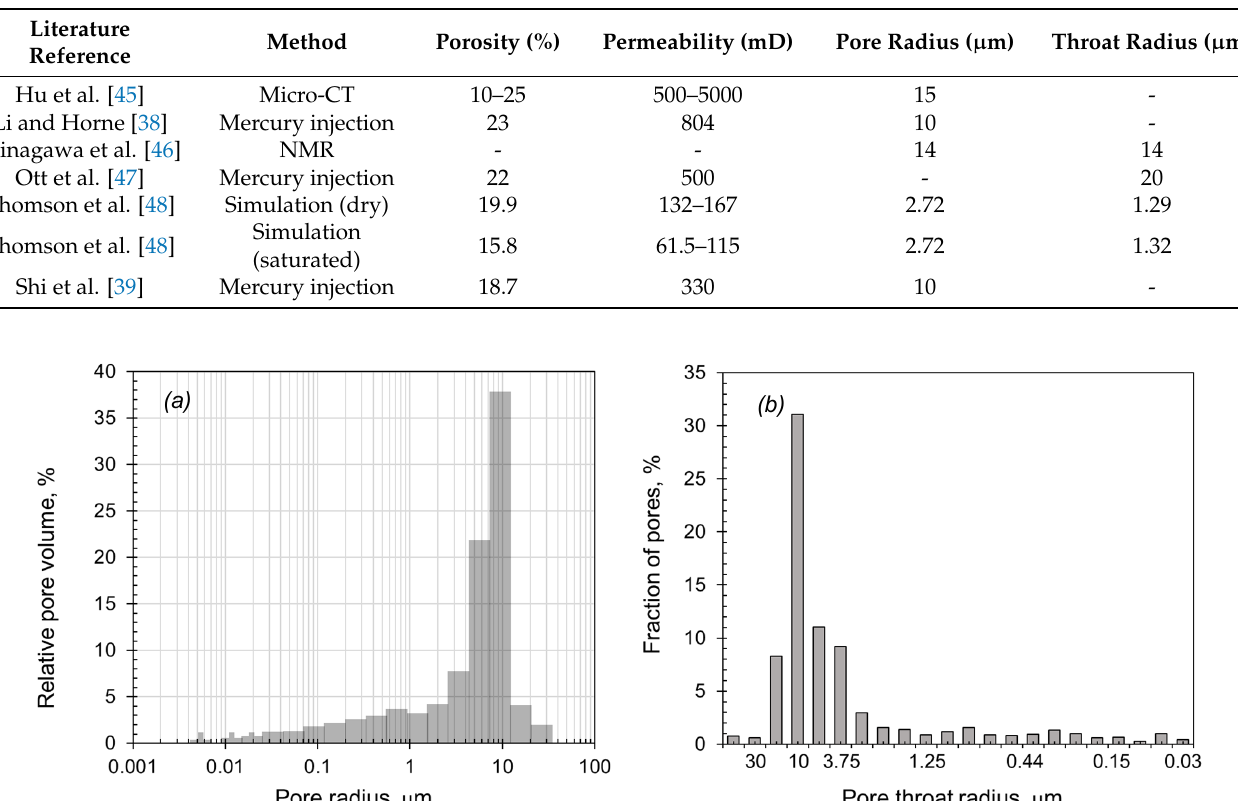
Table 1. Pore and throat radii of Berea sandstone samples with respective porosity and absolute permeability. NMR is the Nuclear Magnetic Resonance.